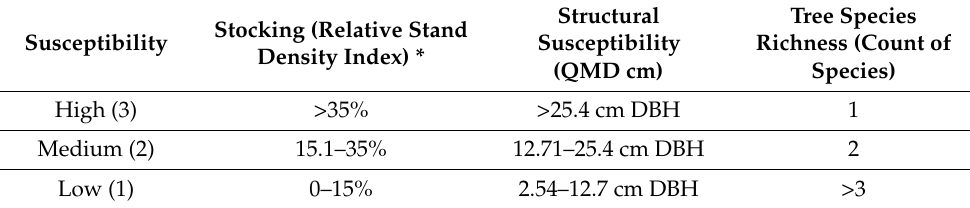
Table 3. The framework for the conceptual landscape model, which maintains the same approach of the individual species susceptibility models, but instead of working stand by stand, our model incorporates the percentage of the area or landscape (two stands, a landscape, a state, etc.) in calculating the susceptibility. Each of the variables are rated as a 1, 2, or 3 and then multiplied by the percent of plots or area to create a landscape susceptibly index (LSI), allowing the comparison across scales while still being able to be utilized at the individual stand level. An example calculation is completed for Colorado (Table 4) this can then be compared against Arizona (Table 5). The model highlights that manipulating any one variable will influence resilience but it is the combination of all three variables which confer resilience. Tree Species Structural Stocking (Relative Stand Richness (Count of Susceptibility Susceptibility Density Index) * (QMD cm)